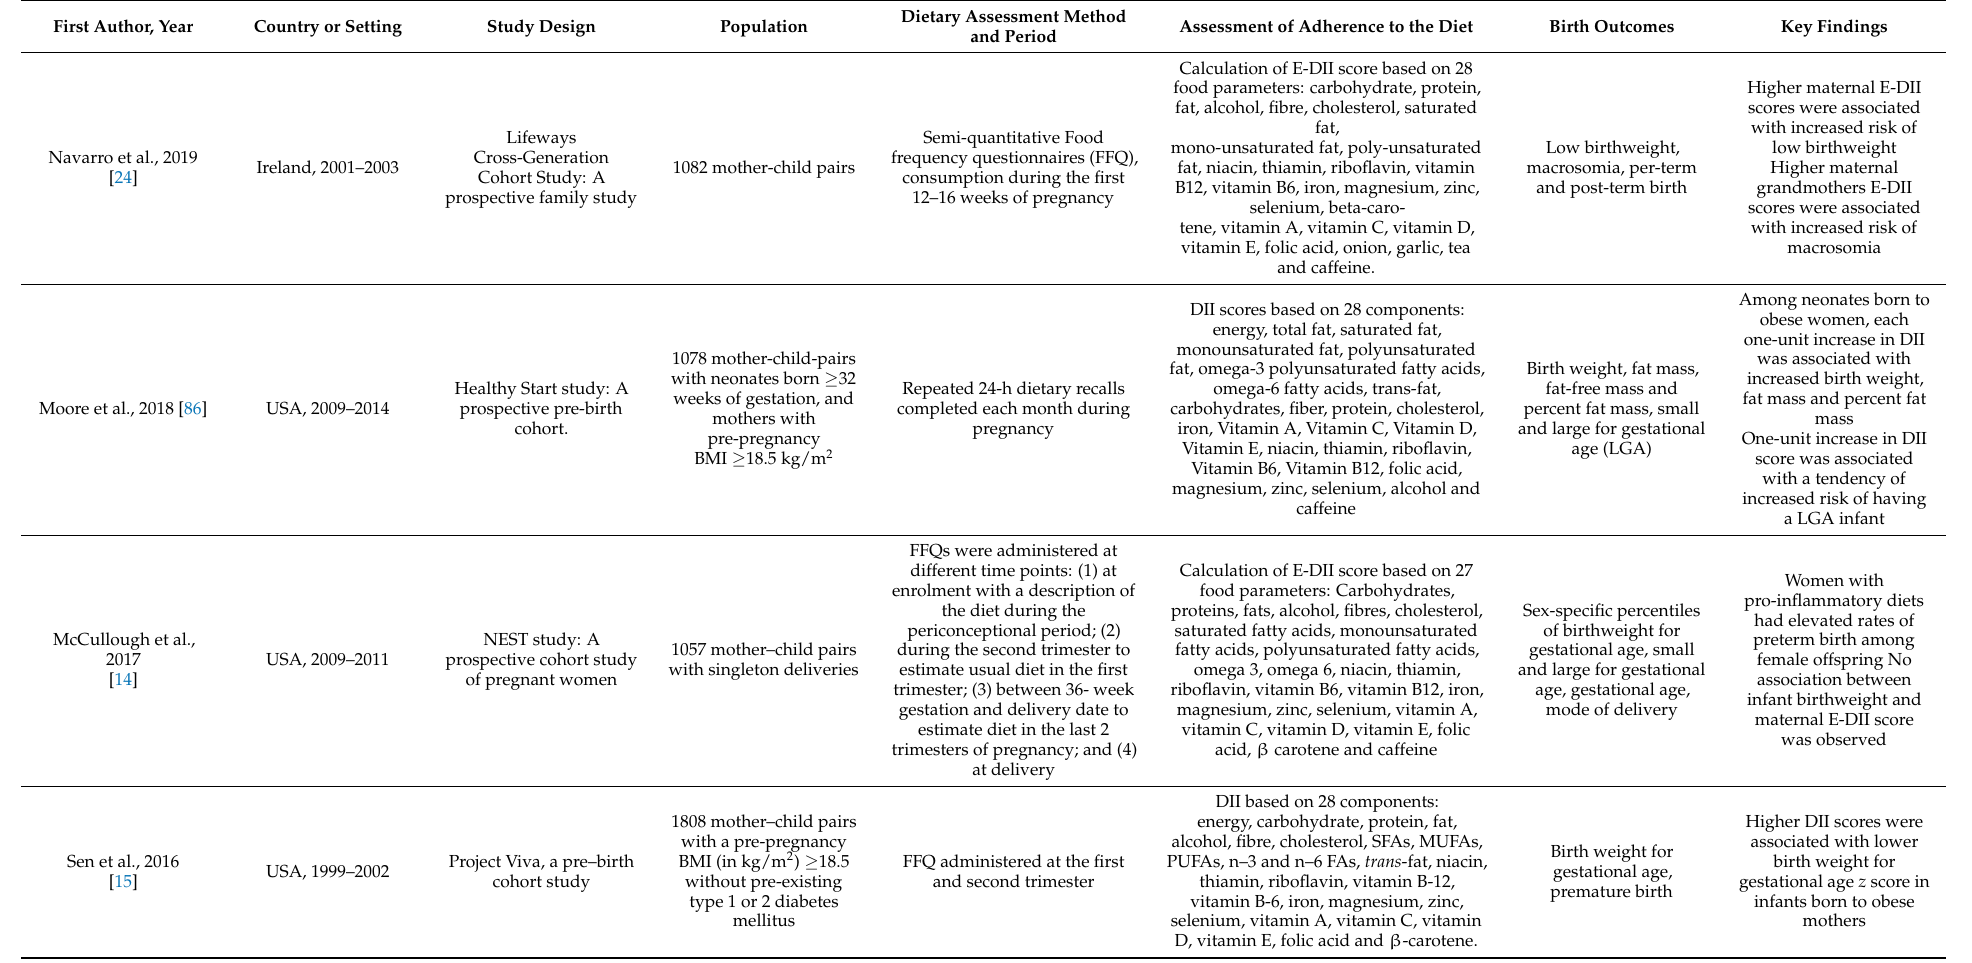
Table 2. Individual studies on the associations between maternal dietary inflammation determined by the DII and E-DII and birth